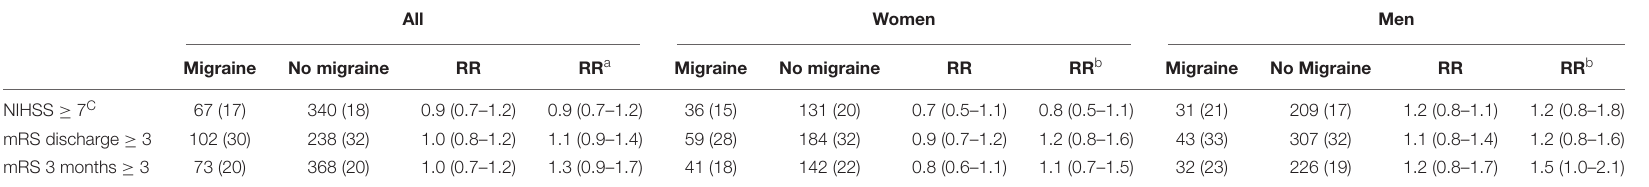
TABLE 3 | Stroke severity and